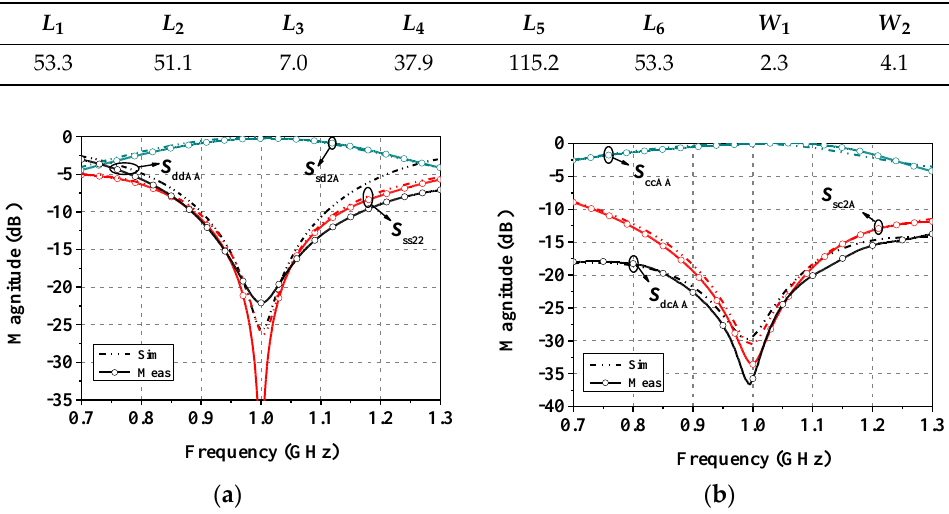
Figure 10. Performances of the proposed balun. ( a ) | S sd2A |, | S ss22 | and | S ddAA |. ( b ) | S ccAA |, | S sc2A |, and | S dcAA |.